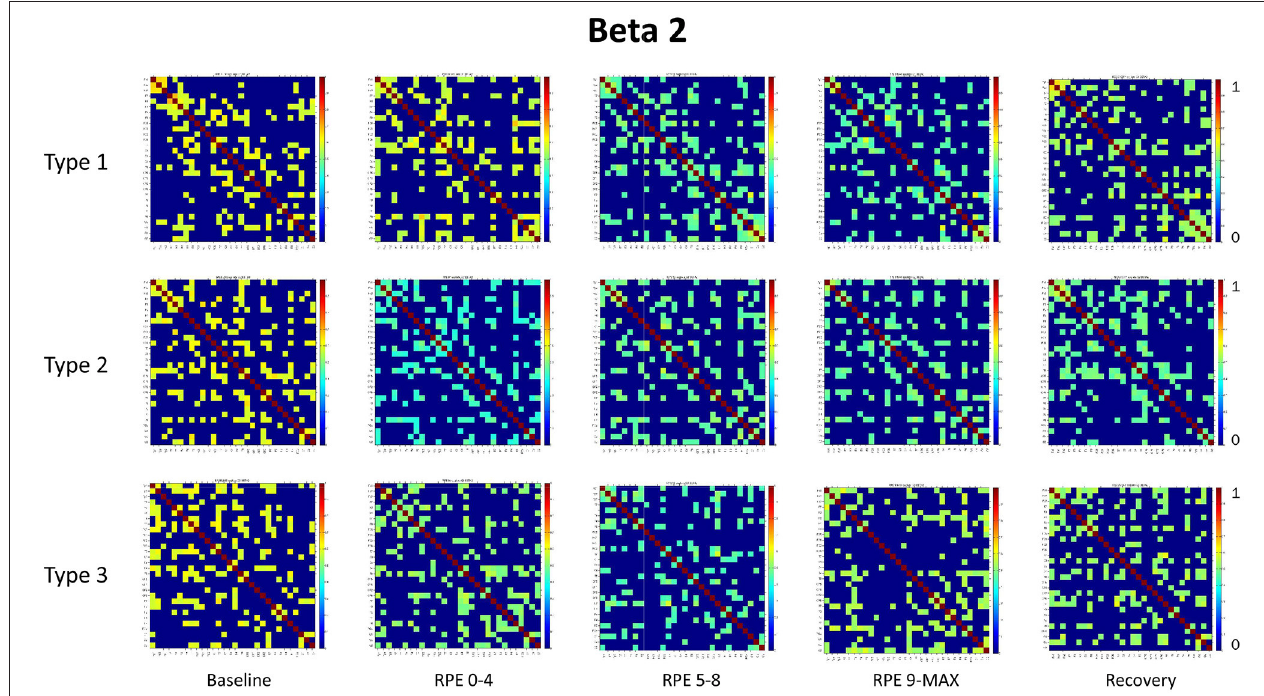
FIGURE 3 | Coherence matrices for each type of performance during different time periods of the protocol in the beta 2 band. Red color indicates high values of coherence whereas the blue color indicates low values of coherence.